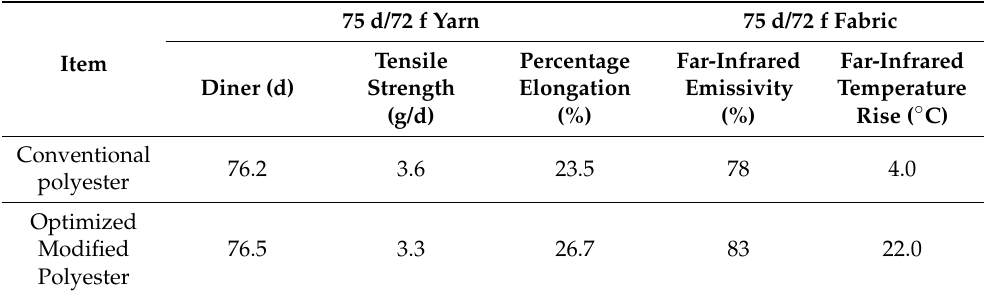
Table 26. Comparison of optimized modified polyester yarns and polyester